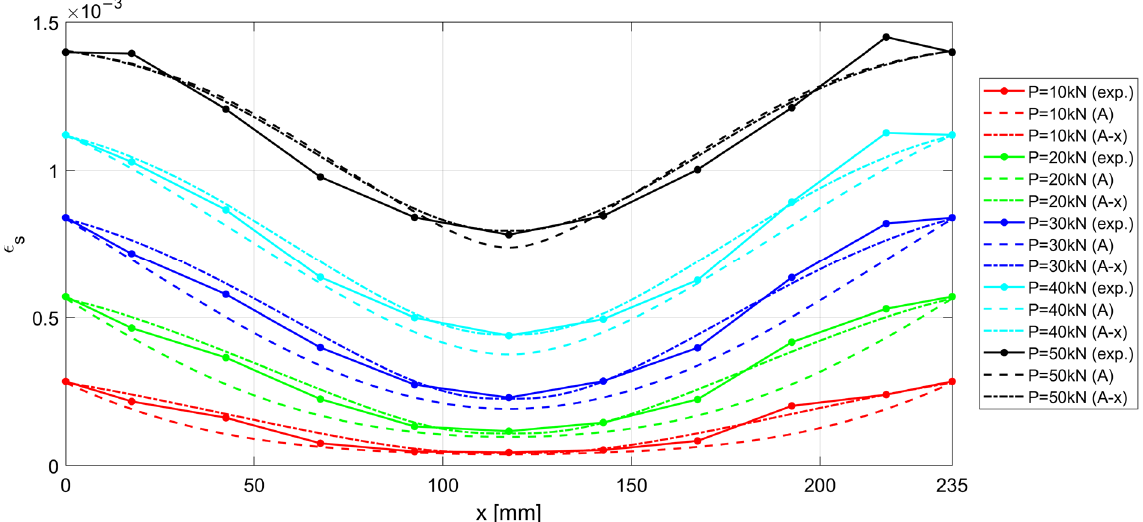
Figure 21. Experimental and numerical ε − x for increasing load P . Two numerical formulations are presented, obtained by considering a fixed bond–slip model (A) and a model with a varying abscissa (A-x).